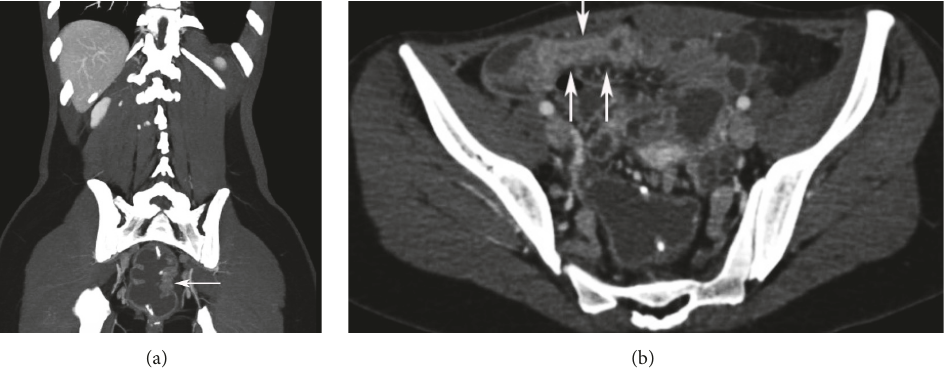
Figure 3: (a) Coronal section of computerized tomographic enterography shows focal mural thickening and enhancement of afferent limb of the J-pouch 1 year after undergoing IPAA and RPC for ulcerative colitis refractory to medical therapy. (b) Transverse section of computerized tomographicenterographyshowsmucosalhyperenhancement,muralthickening,andluminalnarrowingofa9.4cmlongsegmentofterminal ileum 1 year after undergoing IPAA and RPC for ulcerative colitis refractory to medical therapy.